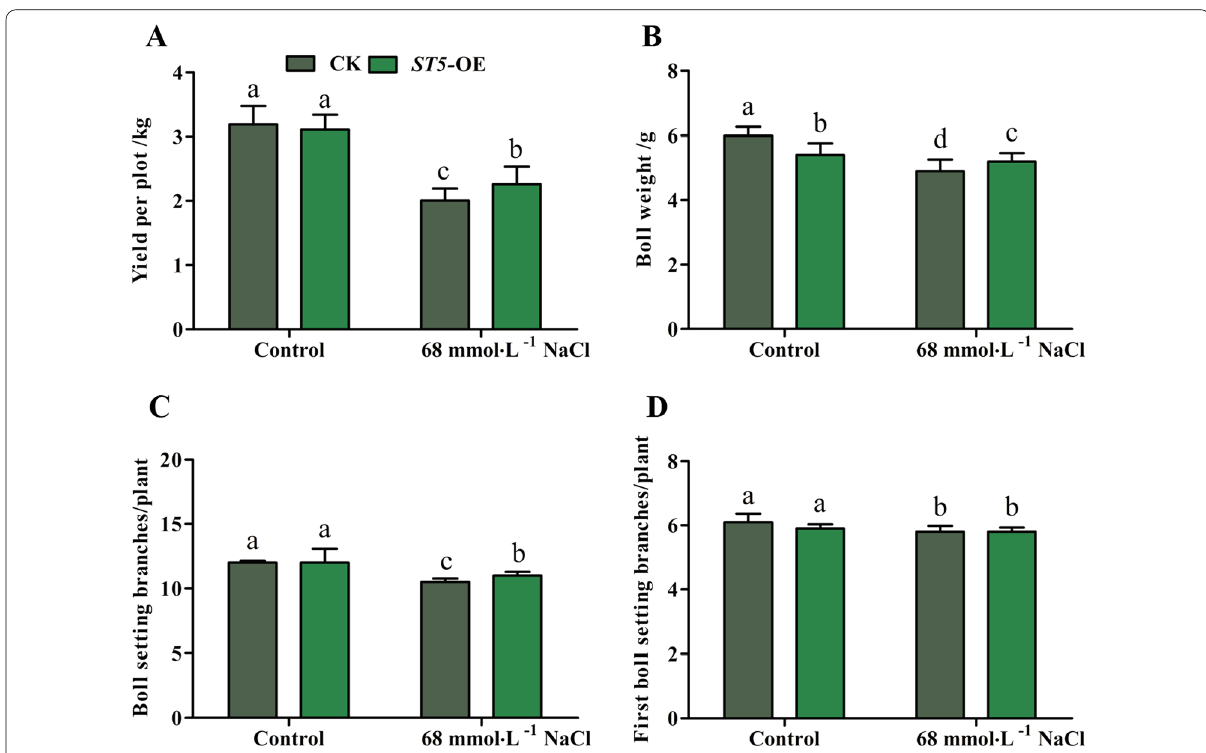
Fig. 5 Improved yield of ThST5 overexpression cotton in saline field. A The seed cotton yield, B the boll weight, C the number of boll setting branches per plant, D the number of first boll setting branches per plant of CK and ST5 -OE in control condition and saline condition. The salt content was 0.4% (68 mmol L -1 ) in the saline field and 0.1% (17 mmol L -1 ) in control field. Values are mean SD of three biological replicates · · ± (each replicate contained 27 plants from each genotype). Different letters represent significant difference ( P < 0.05) as calculated by Duncan’s multiple range